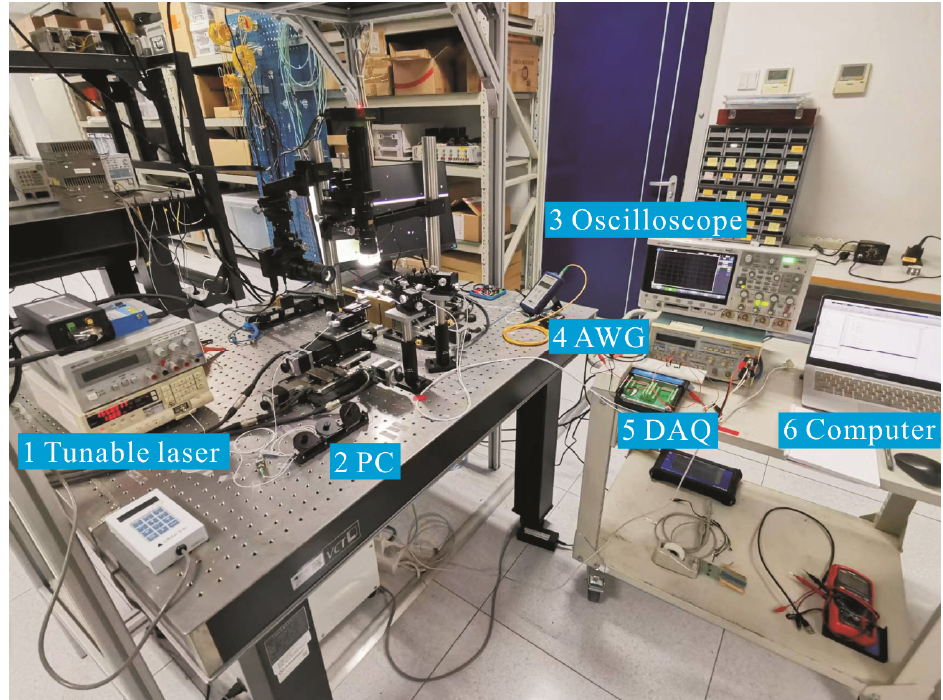
Figure 5. The measurement setup. Table 1. Performance comparison of TFLN modulators.